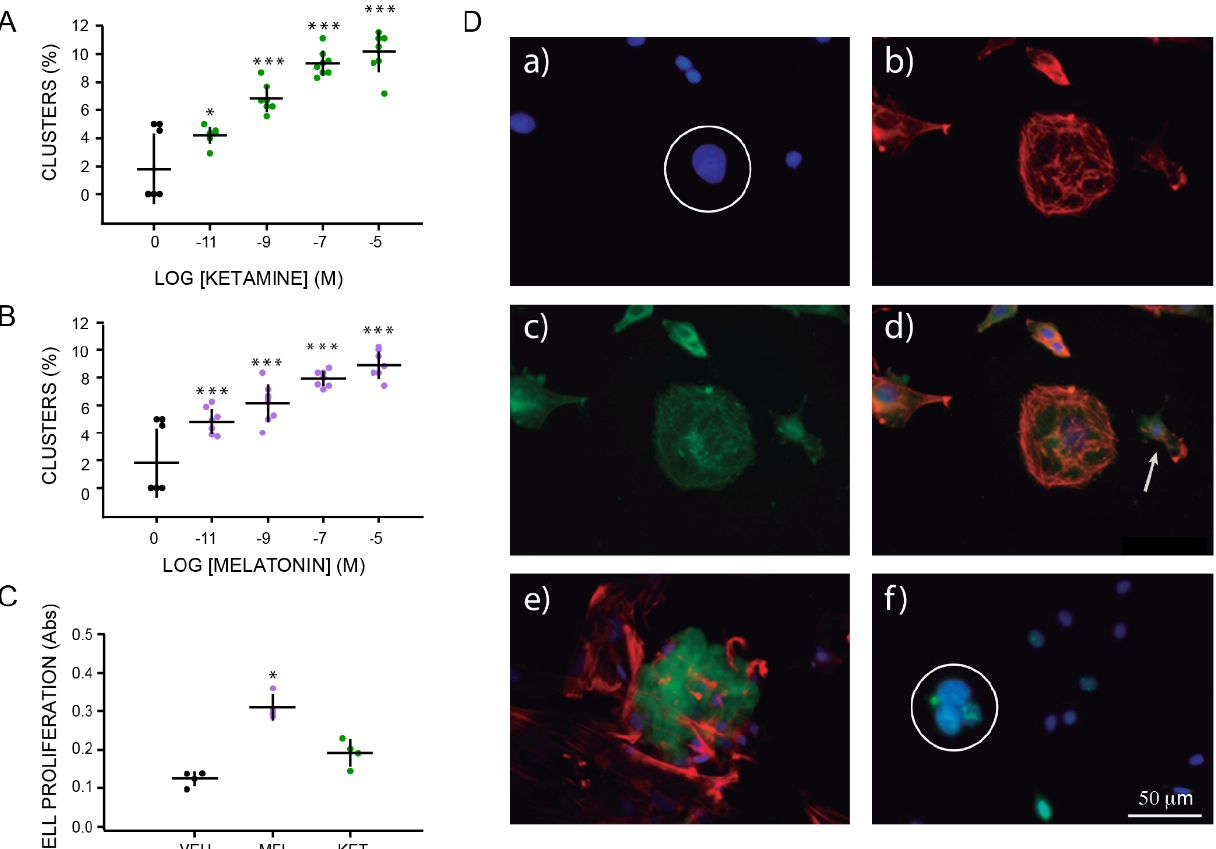
Figure 2. Characterization of clusters formed by olfactory neuronal precursors cultured with either ketamine or melatonin. Graph of the frequency of cluster formation after 6 h of incubation with increasing concentrations of either KET (10 − 11 to 10 − 5 M) or MEL (10 − 11 to 10 − 5 M) are shown in Panels A , and B , respectively. Formation of clusters was evaluated by counting them in each of 10 chosen fields (n = 10) and normalized by the total number of cells per field determined by DAPI staining. Cell proliferation induced by treatment with vehicle (VEH), MEL (10 − 7 M), or KET (10 − 7 M) were measured by the WST1 transformation by mitochondrial enzymes to formazan and shown in Panel C . Each point represents the mean of absorbance values obtained in 4 wells. The mean ± standard deviation of the mean (SEM) is from 1 or 2 experiments performed by quadruplicate. Each experiment was repeated three times. Data were analyzed by one-way ANOVA with Bonferroni’s post-test. * p = 0.009; *** p = 0.001 when compared with vehicle (VEH) control. Cell proliferation was analyzed by Kruskal–Wallis followed by Dunn ´ s post-test p = 0.001. Panel D shows immunofluorescent labeling of ONPs cultured with KET 10 − 7 M during 48 h and stained with DAPI ( a ), phalloidin-TRITC ( b ), and anti-nestin antibody followed by a secondary antibody coupled to FITC ( c ). Merged images show colocalization of these labels (orange) in a spherical cluster ( d ). Im- age e shows a merged image of a spherical cluster simultaneously labeled with an anti-doublecortin antibody followed by a secondary antibody coupled to FITC (green) and phalloidin-TRITC (red). A representative image of clusters stained with DAPI (blue), pre-labeled with BrdU and stained with a specific anti-BrdU antibody (green) is shown in image f . Spherical clusters are noted by a white circle in images a and f . A single cell is noted in d with an arrow. Bar = 50 µ